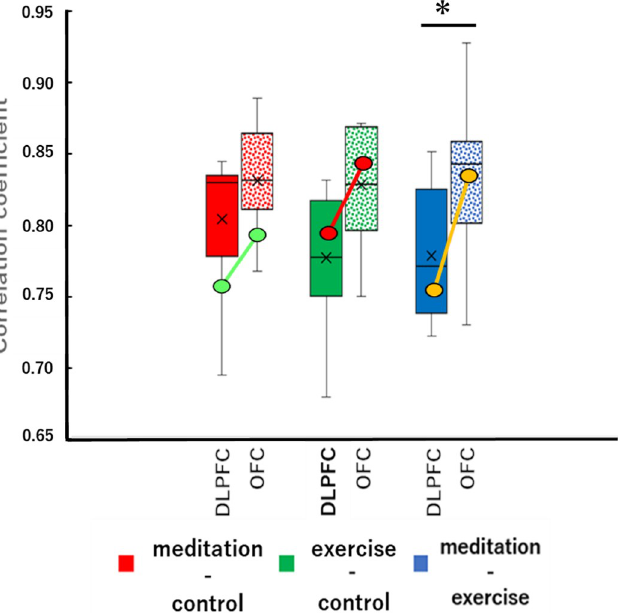
Fig 5. Correlation coefficients of the FFT-analyzed NIRS frequency at the DLPFC and the OFC for the meditation-control pair (red), the exercise-control pair (green), and the meditation-exercise pair (blue). A Mann- Whitney U -test was performed after an F test for equal variance. � p < 0.05. The diagonal lines show the changes in mean values obtained from the 2 left-handed participants.